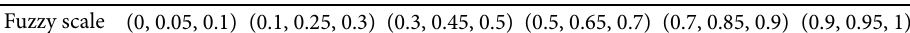
Table 4. Linguistic variables for fuzzy scale Condition